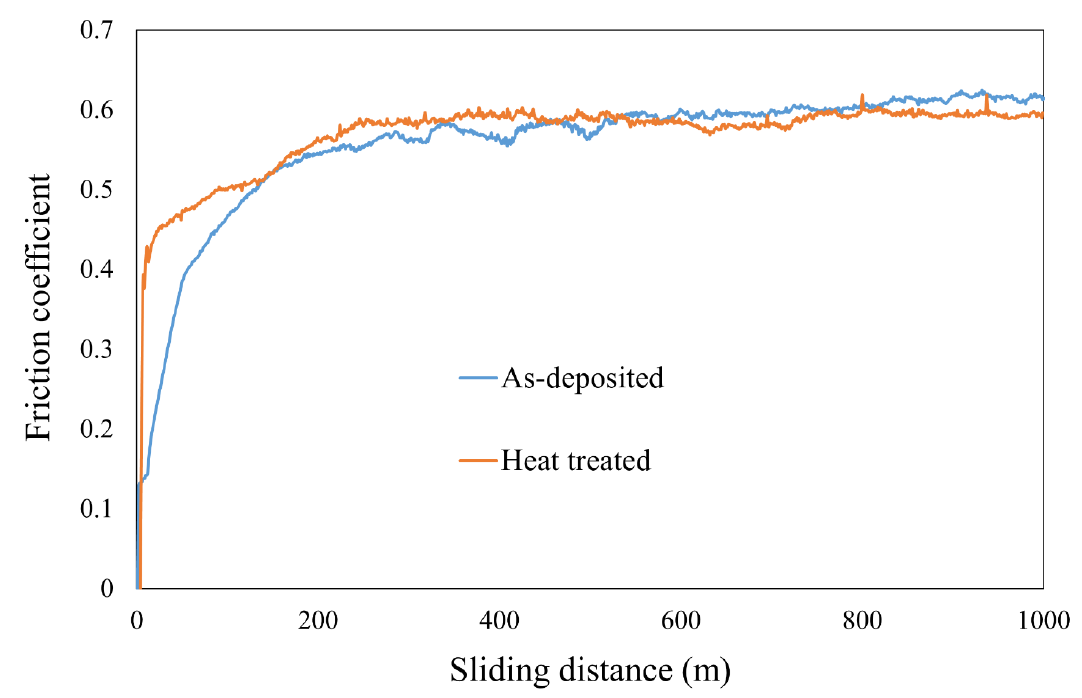
Figure 10. Evolution of friction coefficient of the as-deposited and heat-treated samples recorded during 1000 m of ball-on-flat sliding test.